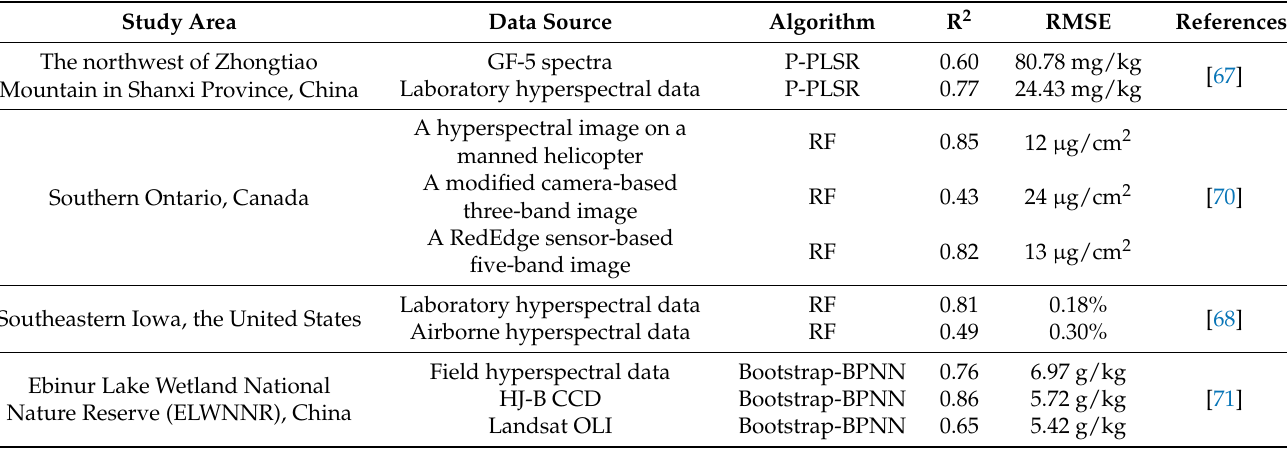
Table 3. The comparison of results with different data sources among other